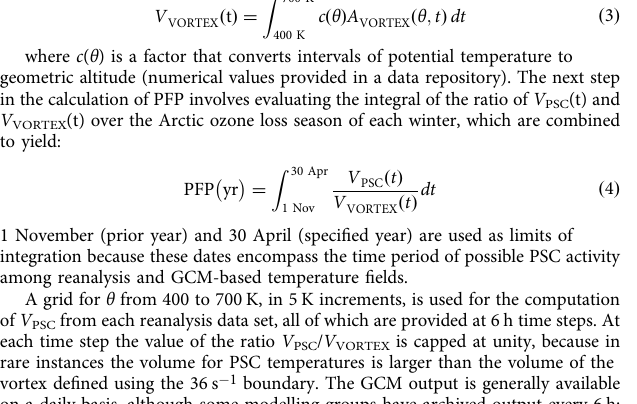
Fig. 1 is based on perturbation of the reanalysis temperature fi eld by ±1 K; this magnitude of the offset is based on our analysis of the approximate 1 σ standard deviation about the mean of stratospheric temperature from the four data centres, over the modern satellite era. In the main article, we estimate PFP using the JRA-55 and ERA5/ERA5.1/ERA5 BE (preliminary version) reanalysis products over 1965 – 2020, as well as 1980 – 2020.